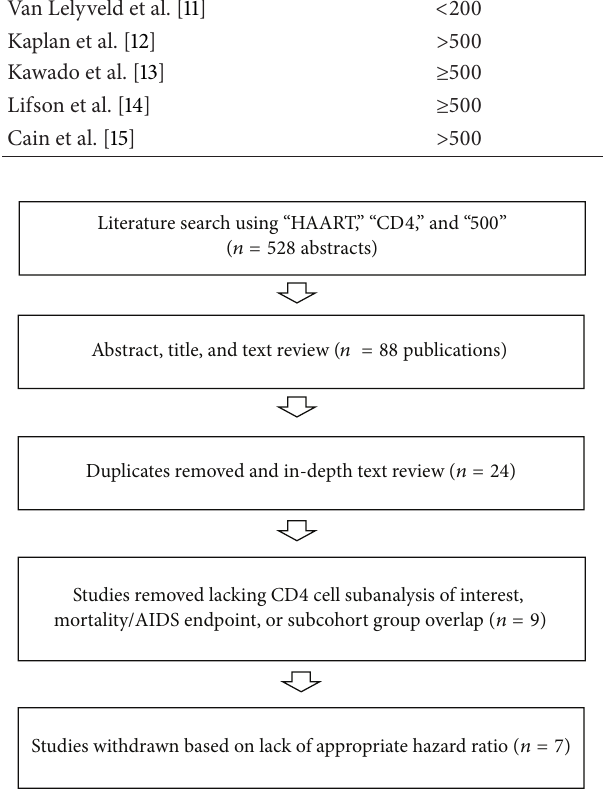
Figure 1: Flow chart of literature search